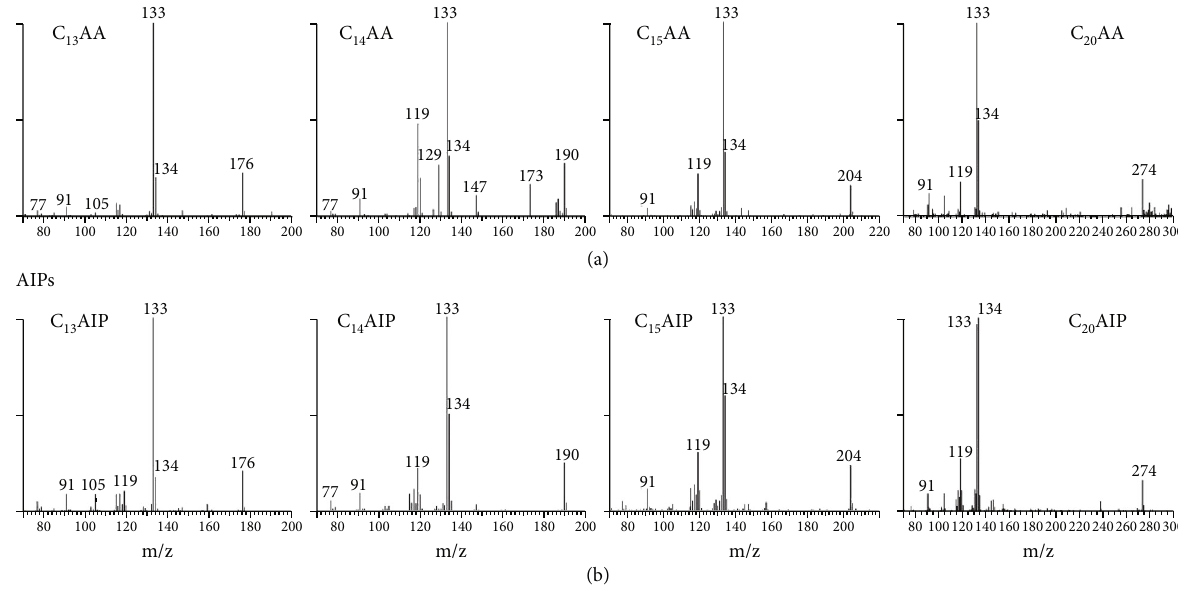
Figure 2: Mass spectra of (a) AAs and (b) AIPs obtained from the monoaromatic oil fractions in the Tarim Basin.